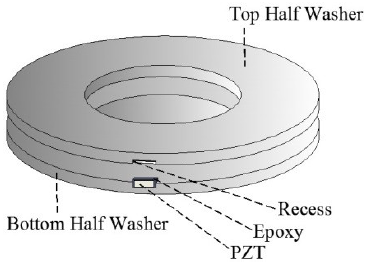
Figure 7. The design of a smart washer (SW) [97].